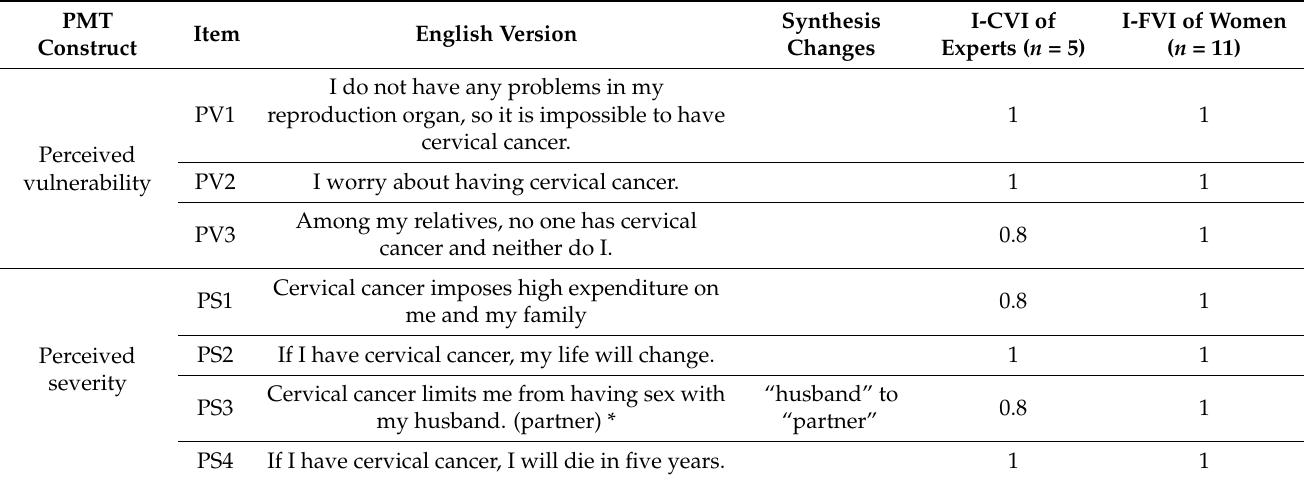
Table 1. The cross-cultural adaptation, content validity, and face validity index of the Malay version of the PMT